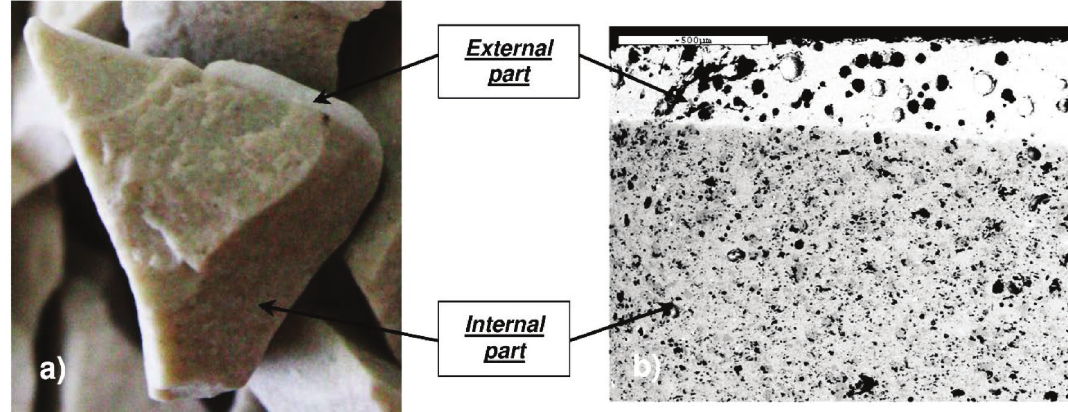
Fig. 1. Recycled ceramic aggregate: a) General aspect; b) BSE image (×